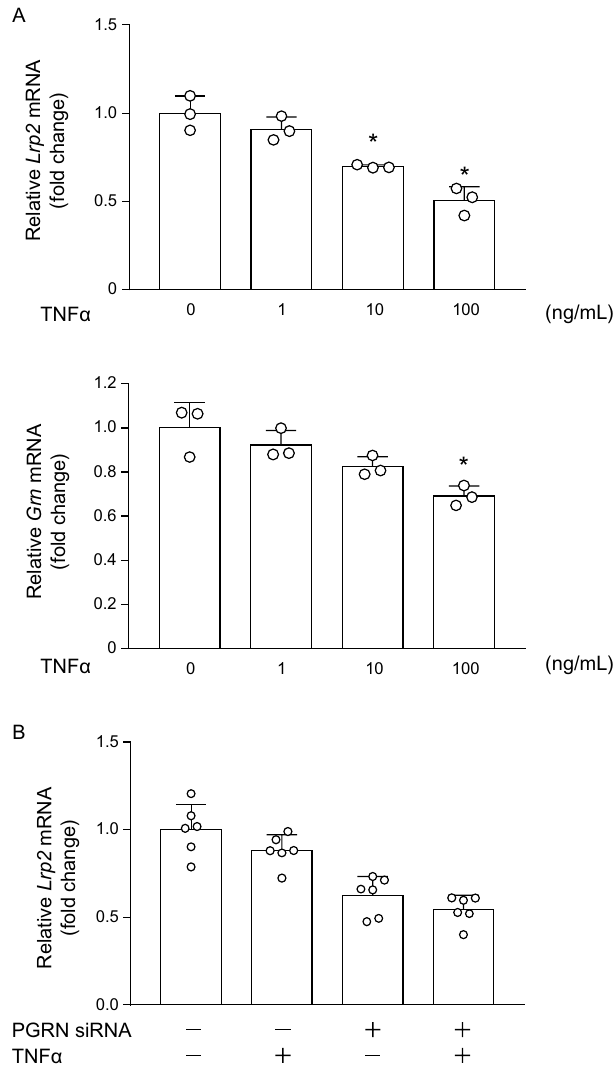
Figure 7. mRNA expression levels of Lrp2 and Grn in cultured mouse PTECs stimulated with TNFα. ( A ) The mRNA expression levels of Lrp2 and Grn are reduced in a dose-dependent manner in PTECs stimulated with TNFα. Tukey’s honestly significant difference test. * p < 0.05 versus no TNFα stimulation. ( B ) Effects of PGRN siRNA on megalin expression in PTECs stimulated with 10 ng/mL TNFα. Two-way ANOVA shows significant main effects of PGRN knockdown and TNFα stimulation on the expression of megalin ( p < 0.01 and p = 0.04, respectively), without significant interaction ( p = 0.64), showing that knocking down PGRN reduces megalin